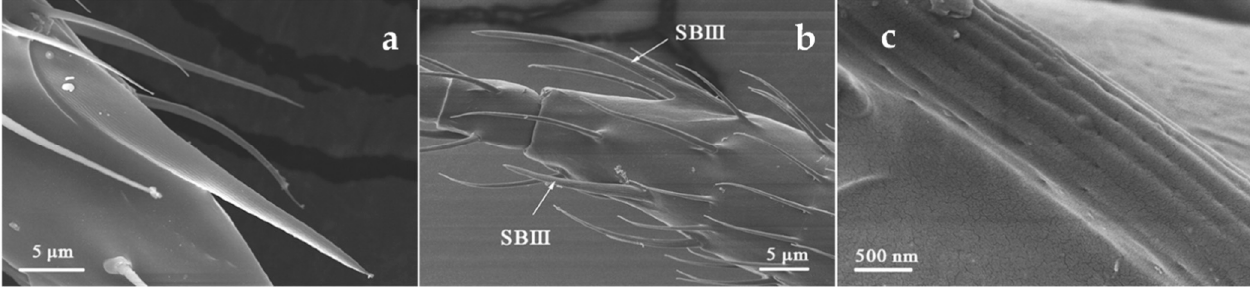
Figure 5. Sensilla basiconica III (SBIII) on the flagellum IV of O. loti ( a ), S. kaszabi ( b ), and SBIII ( c ) shown in high resolution.